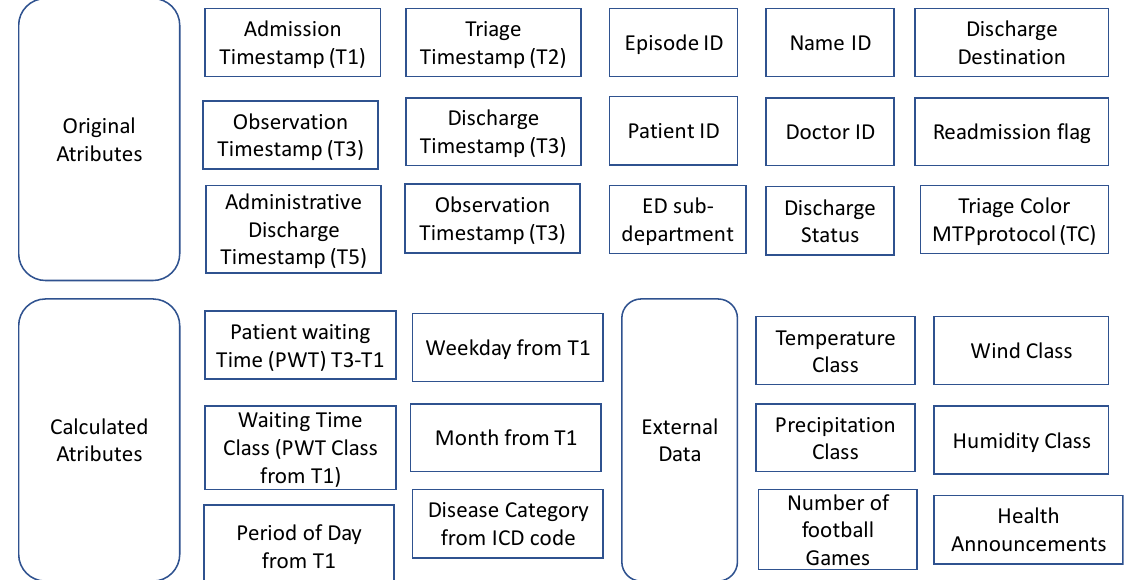
Figure 6. Data integrated from a hospital in Lisbon using the proposed ETL process.